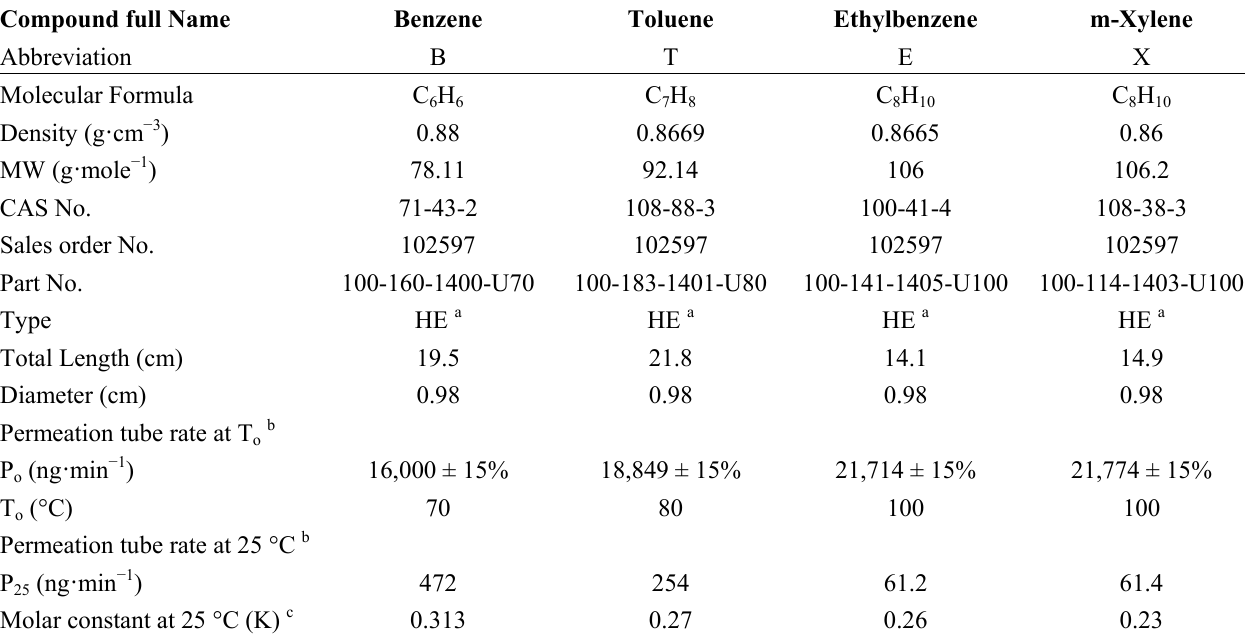
Table 1. Basic information of permeation tube used for the generation of target compounds (BTEX) used in this